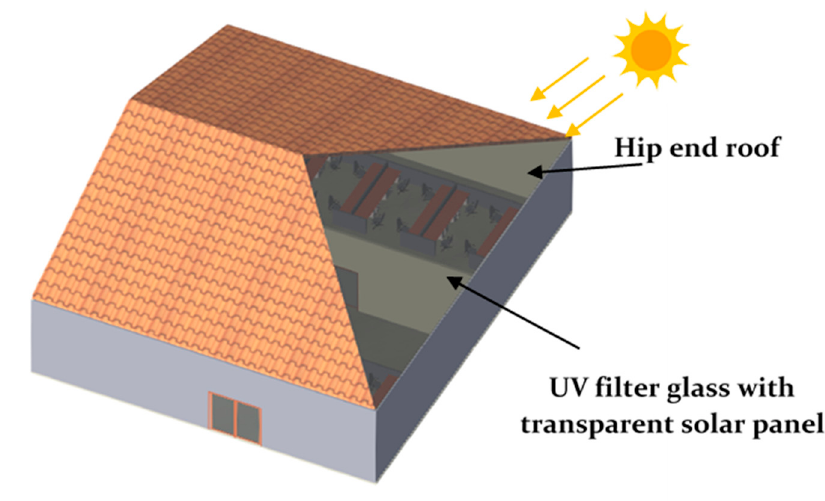
Figure 12. Roof structure with UV filter glass with a transparent solar panel.